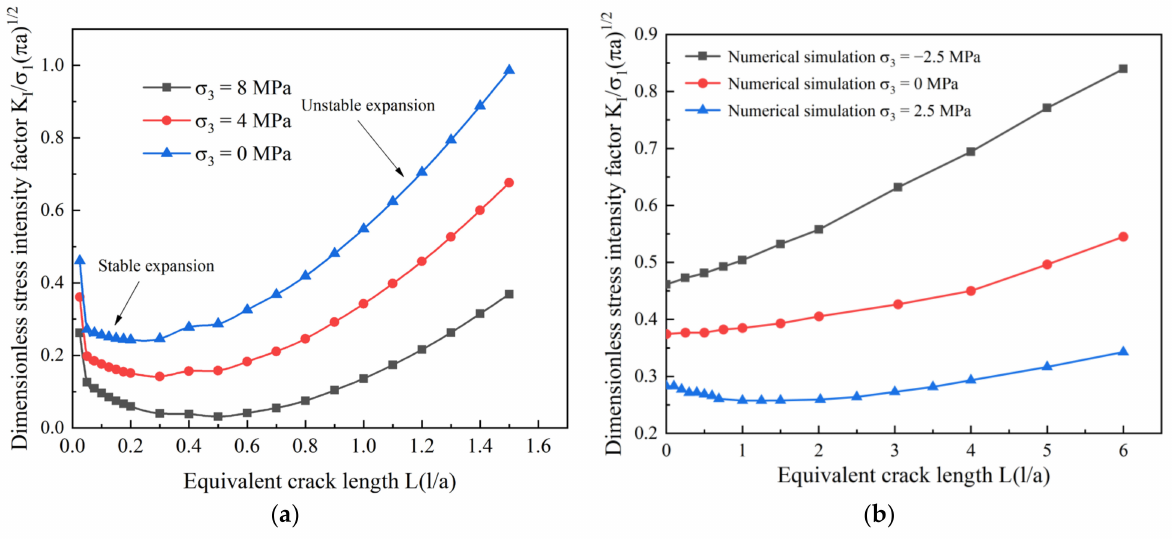
Figure 6. The relationship curves between dimensional stress intensity factor at the crack tip wing stress and crack propagation length under different confining pressures. ( a ) Theoretical